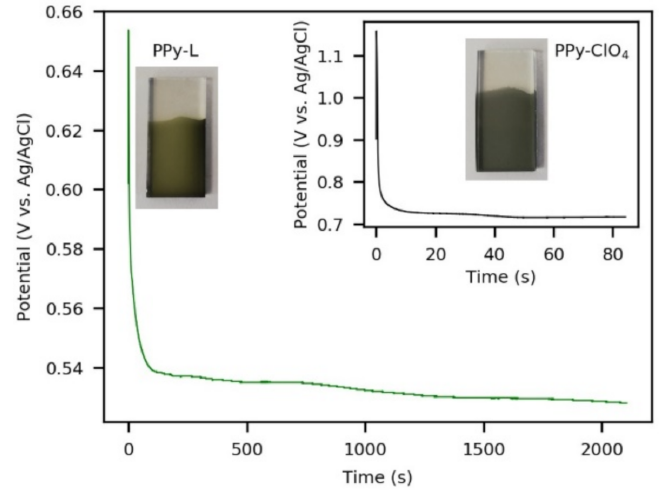
Figure 2. Galvanostatic polymerizations of ClO 4 − -doped polypyrrole (PPy-ClO 4 ) and TPPS-doped polypyrrole (PPy-L). In both cases, the electric charge supplied was 42 mC/cm 2 .